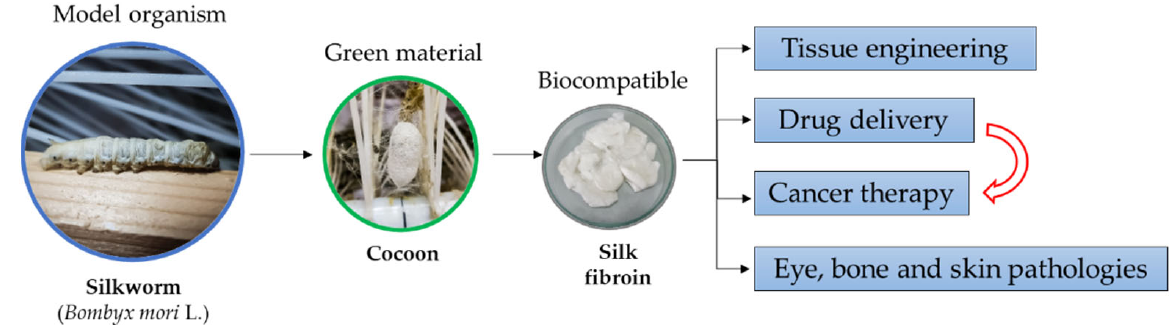
Figure 1. Schematic representation of SF main applications.